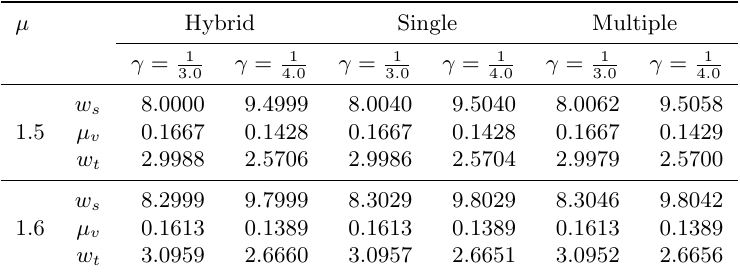
Table 2: Performance measures for the M/G/ 1 / 3 /V and hybrid